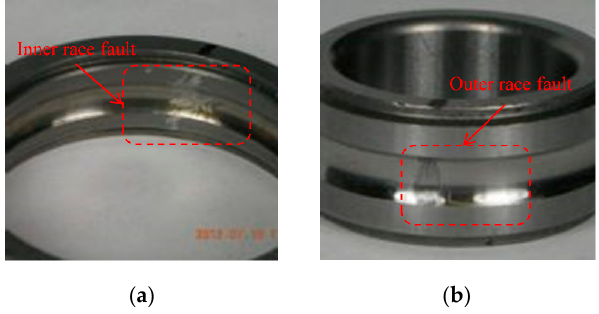
Figure 17. The two bearings from MFPT data sets: ( a ) inner race fault (IRF); ( b ) outer race fault (ORF). Test accuracy of different models under different SNR on MFPT are shown in Figure 18 and Table 10. Although RNN and CNN have obtained high accuracy on the MFPT data set, the ALSCN still leads under five kinds of SNR conditions.